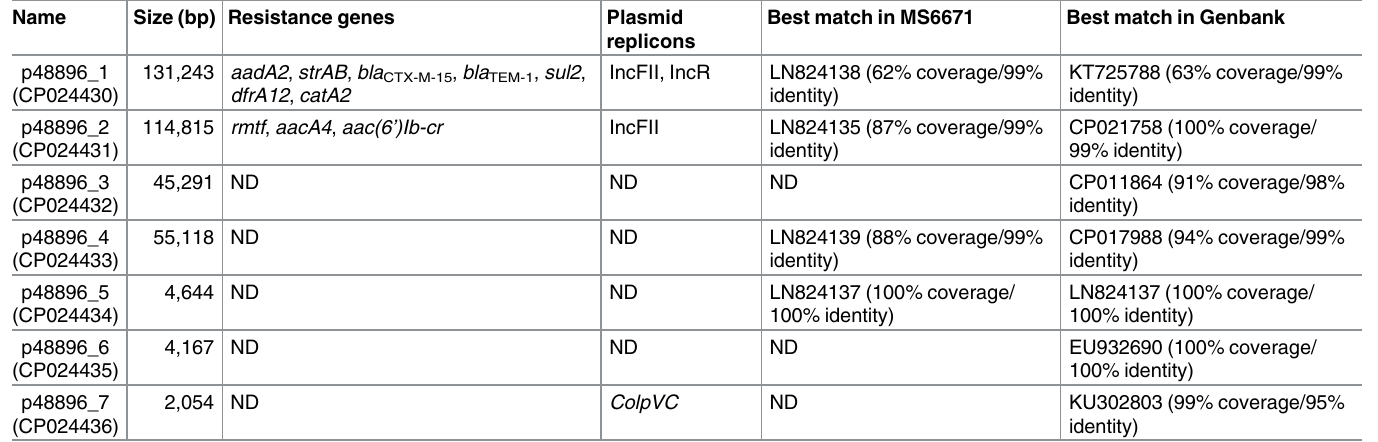
Table 2. Plasmids found in